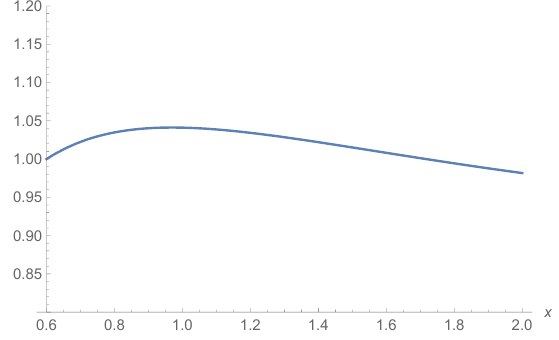
( Y ) ( x ) of the distribution functions of X and X ( Y ) u , t